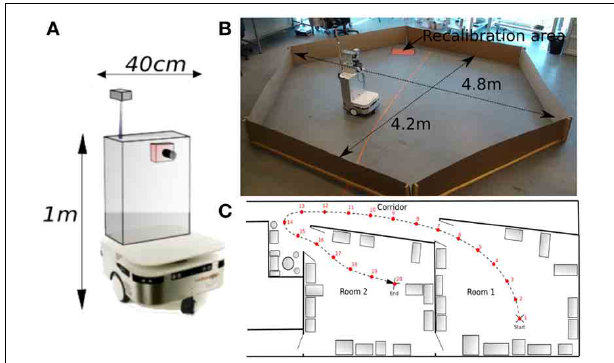
FIGURE 5 | (A) Robotic platform used to perform our experiments. (B) Grid cells Experiments (1–5): Our 1 m high, 40 cm wide robot is freely moving in a 4 m diameter hexagonal enclosure using random movements and obstacles avoidance. The system learns by a few place-action associations how to return to a “home” location (marked by a red paper on the floor), that allows the robot to recalibrate itself. An internal time counter pushes the robot to go recalibrate itself every X minutes (X depending on the experiment), in order to limit cumulative errors of path integration. (C) Multiroom environment used to study place cells response (Experiments 8–11). The robot learns 19 regularly-spaced places (each 1.5 m), starting from a room, passing through a corridor and ending on a second